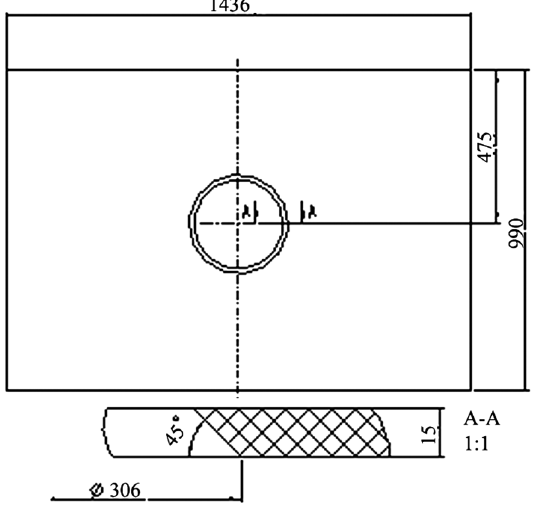
FIG. 11. (a) Waveforms of the diode voltage U , diode current I , and one-dimensional space charge limited current Icl at 95 kV charging voltage. (b) Calculated traces of the diode power P and energy W